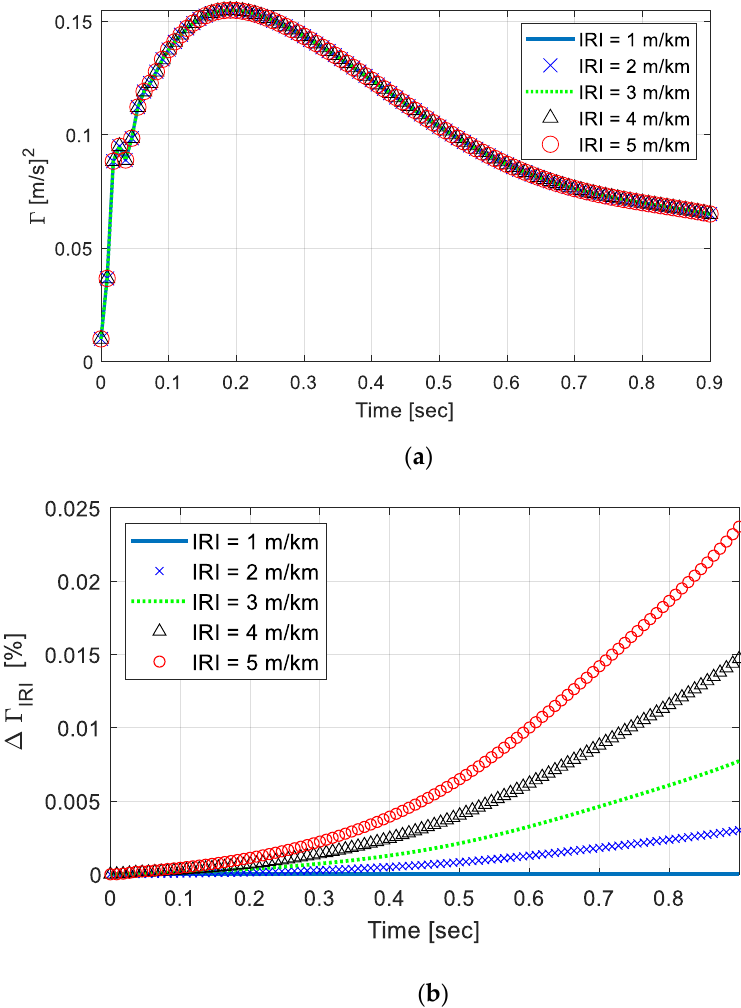
Figure 4. ( a ) Covariance response of vehicle under varying IRIs. ( b ) Difference in the response among IRIs in percentage.